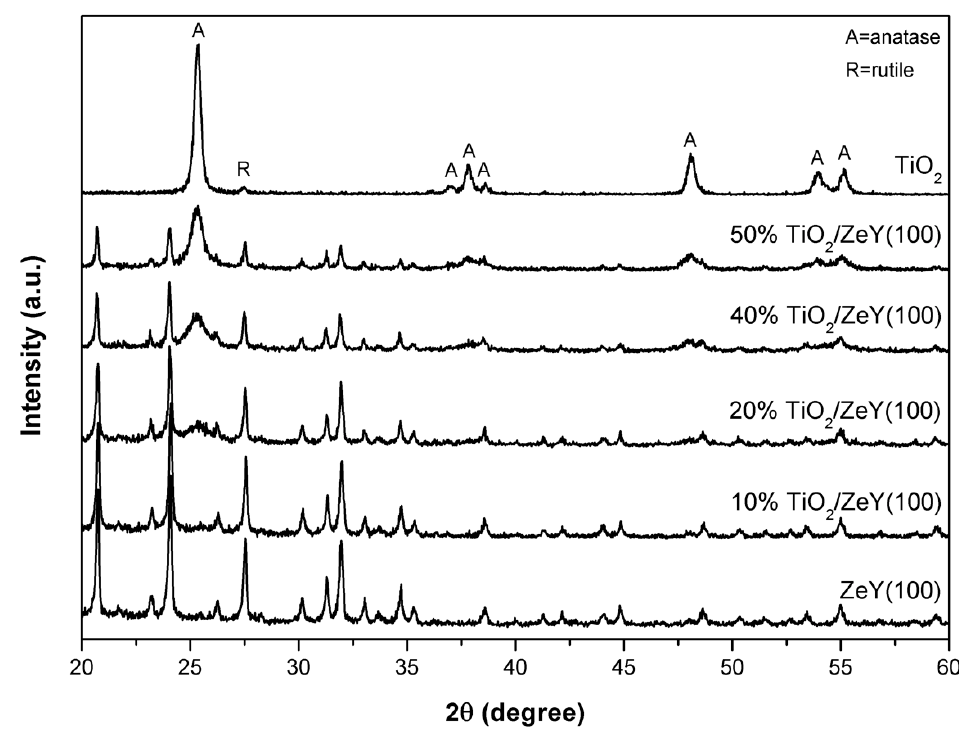
Figure 2. XRD patterns of TiO 2 , TiO 2 /ZeY (at different amounts of TiO 2 ), and ZeY (at different ratios of SiO 2 :Al 2 O 3 ).